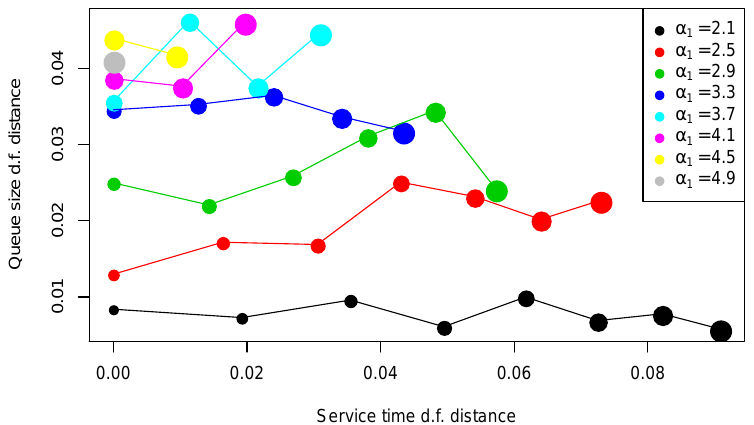
Figure 8. Distance between the empirical queue size d.f. in a basic M / G / c system with c = 4, F 1 being Pareto ( α 1 ,1 ) service time d.f., and system with a mixture, F M of Pareto ( α 1 ,1 ) and Pareto ( α 2 ,1 ) service time d.f. vs. the distance between F 1 and F M , for fixed p = 0.7, fixed ρ = 0.5, varying α 1 = 2.1,2.4, . . . ,4.9 (color), varying α 2 = α 1 , α 1 + 0.4, . . . ,4.9 (dot size), and varying λ , so as to fix the load, ρ